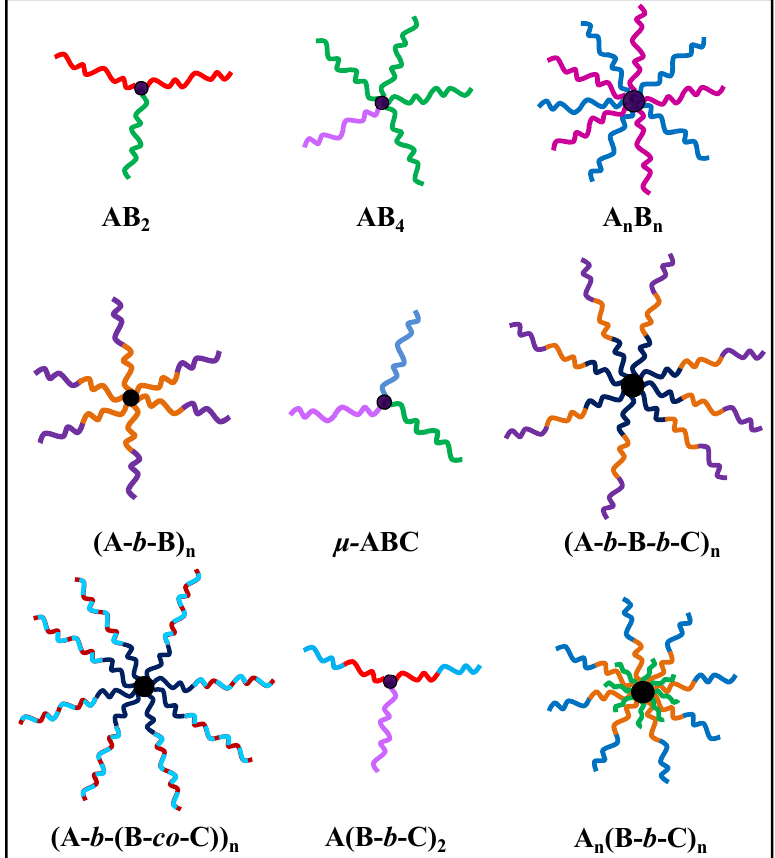
B heteroarm n n star block copolymer, n , A (B- b -C) heteroarm star block 2 n n